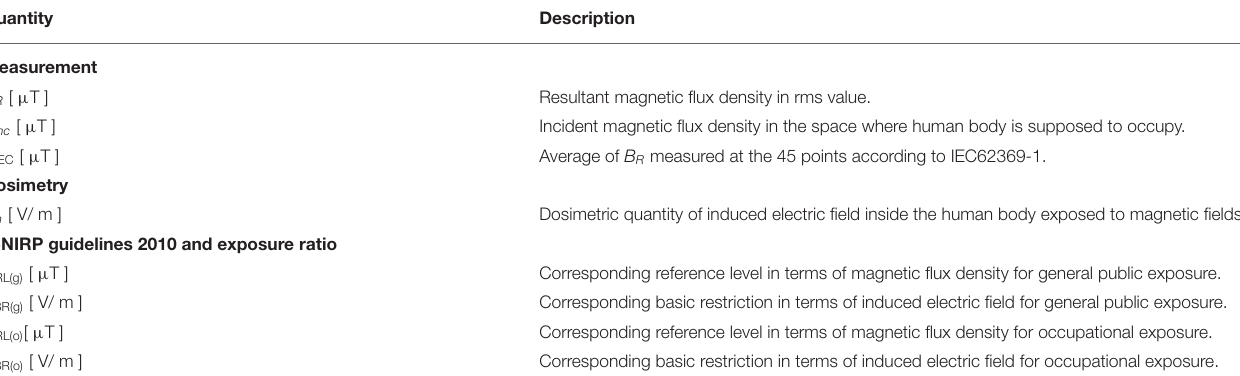
TABLE 5 | List of quantities with